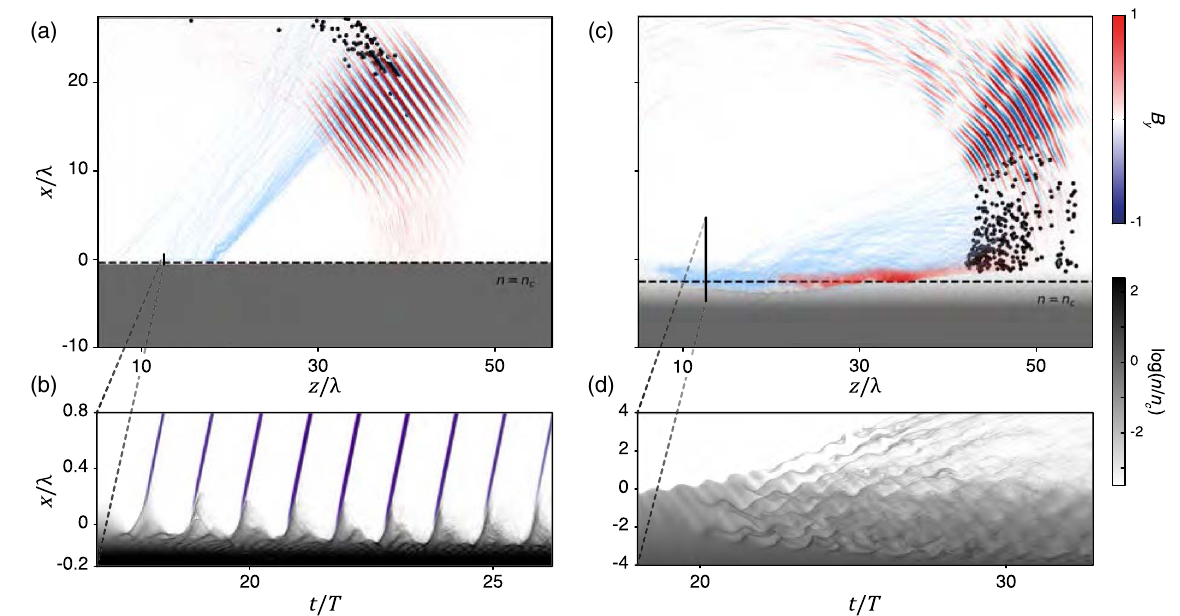
FIG. 7. 2D PIC simulations in the two distinct regimes of laser-plasma coupling. These data are obtained from 2D PIC simulations with different density gradients L [ λ = 15 for (a) and (b), and λ = 1 . 5 for (c) and (d)], while all other physical parameters remain the same ( a 0 ¼ 3 . 5 , θ i ¼ 55 °). The two upper panels display the complete trajectories of a selected set of expelled high-energy test electrons (blue lines), together with the y component of the magnetic field (blue to red color map) at a given time after the laser-plasma interaction. The plasma density profile at the end of the interaction is indicated in gray in log scale. The lower panels shows the temporal evolution of the plasma electron density (gray scale color map, in log scale), spatially resolved along the normal to the target surface, at the center of the focal spot. The emitted attosecond pulses are overlaid to this density map in purple. They are clearly visible in (b), but are too weak to be observed in